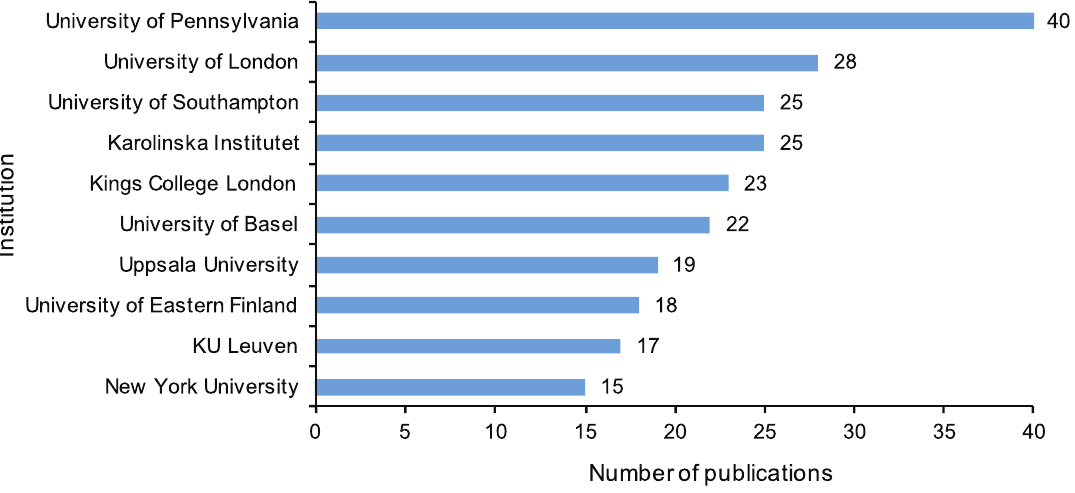
Figure 6: Information of the top 10 institutions that contributed the most citations to Research Frontier